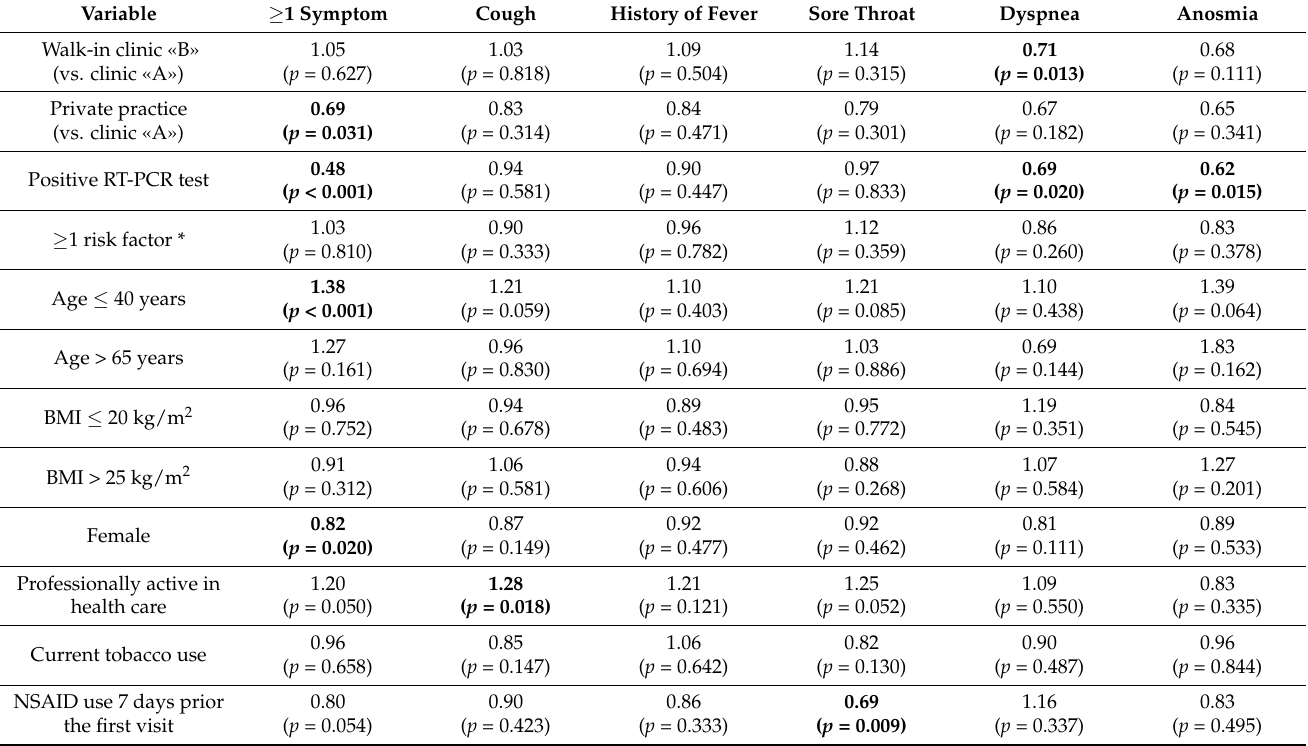
Table 3. Pooled hazard ratios (HR) and their p -values from multivariate Cox proportional hazards regression models for symptoms duration. COVID-AMBU study, Switzerland, March–July